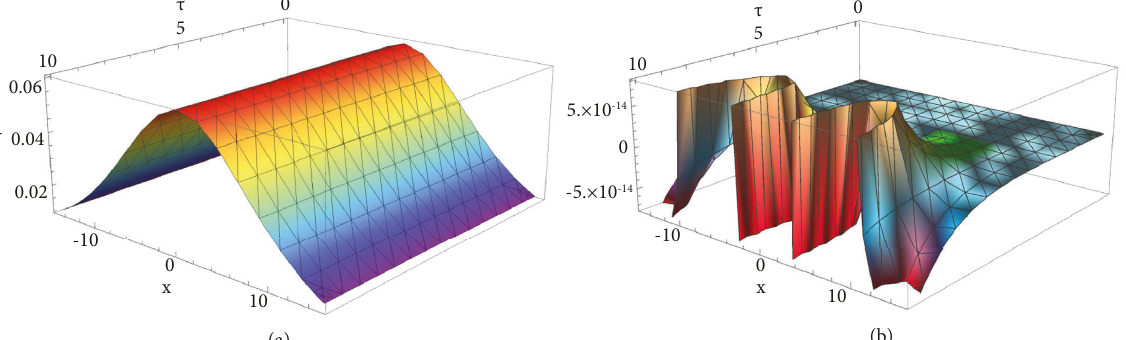
(a) Figure 5: 3D plot of solution and error in Example 2 when α � 1 and ρ � 0.1. (a) Solution. (b) Error.